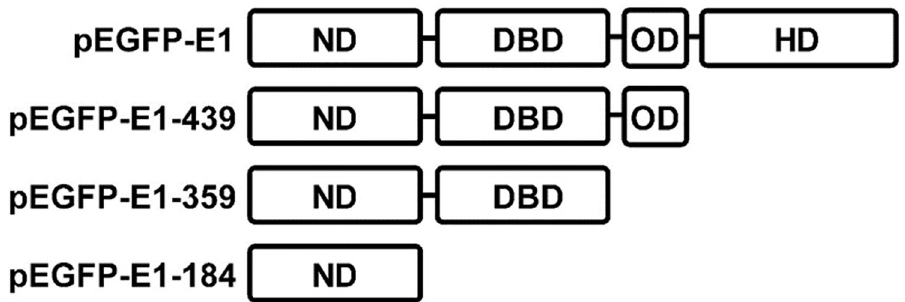
Fig 3. Truncated pEGFP-E1 plasmids and corresponding domains. ND: N-terminal domain, DBD: DNA binding domain, OD: oligomerization domain, HD: ATPase helicase domain. https://doi.org/10.1371/journal.pone.0260841.g003 pEGFP vector control. The mean OD450 of pEGFP vector at 24 and 36 hours, post-transfec- tion was 1.83 and 1.98, whereas the mean OD450 for E1 transfected cells was 0.98 and 0.72 (Fig 5). Taken together, the results concluded that full-length E1 strongly inhibited cell prolif- eration at a statistically significant level in all experiments. It was also noted that only cells transfected with full-length HPV16 E1 exhibited decreased cell viability (Fig 5).